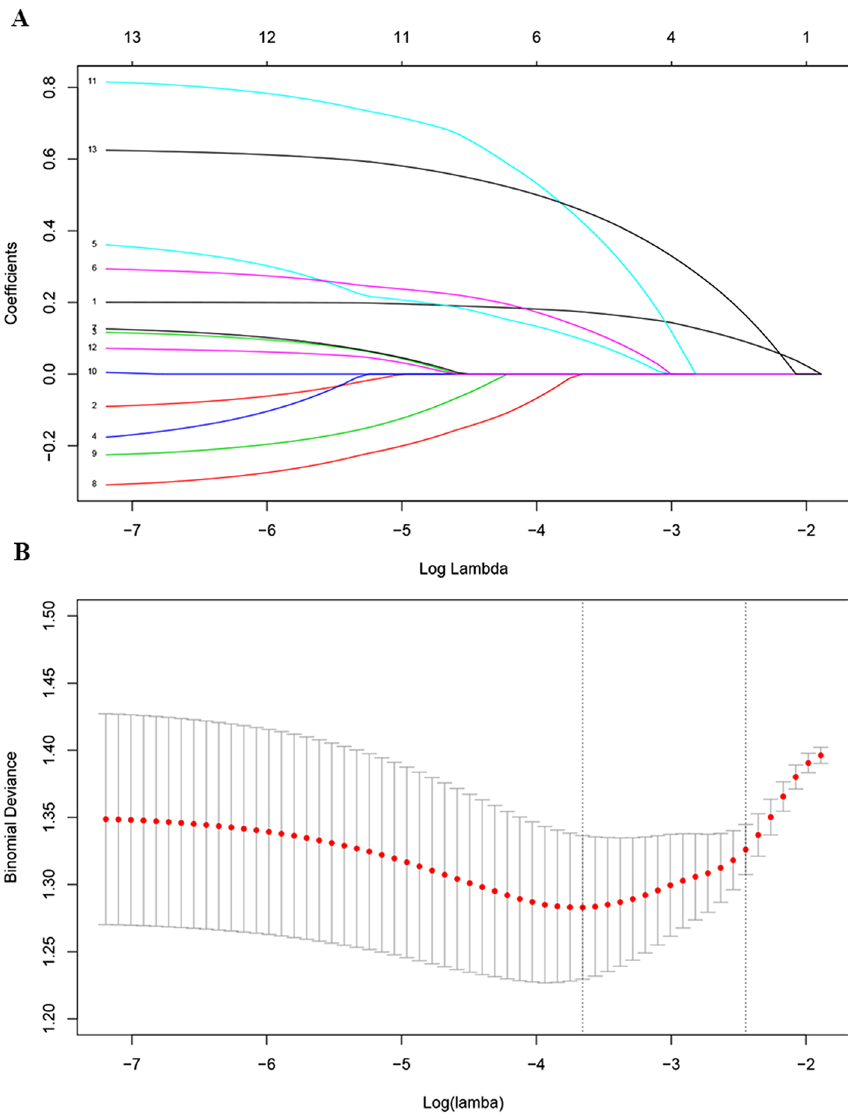
Figure 2. Nomogram model elements selection using the LASSO binary logistic regression model. ( A ) The LASSO coefficient profiles of the 13 features. AST, GGT, TB, AFP and tumor diameter were selected using LASSO binary logistic regression analysis. The LASSO coefficient profiles of the features were plotted. ( B ) The optimum parameter (lambda) selection in the LASSO model performed ten-fold cross-validation through minimum criteria. The partial likelihood deviance (binomial deviance) curve was presented versus log (lambda). Dotted vertical lines were showed at the optimum values by performing the lambda.min and the